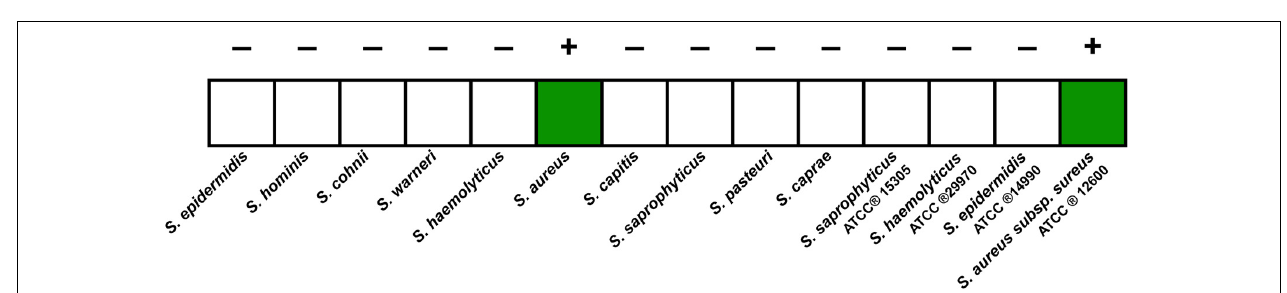
FIGURE 6 | Results of the LAMP-CRISPR assay for 14 strains of staphylococci species.